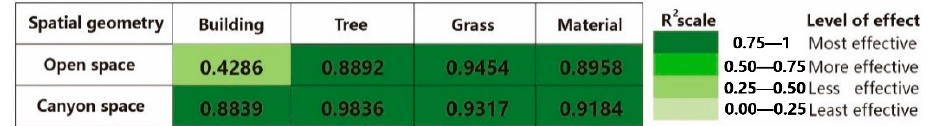
Figure 22. Correlation between different parameter and thermal comfort.